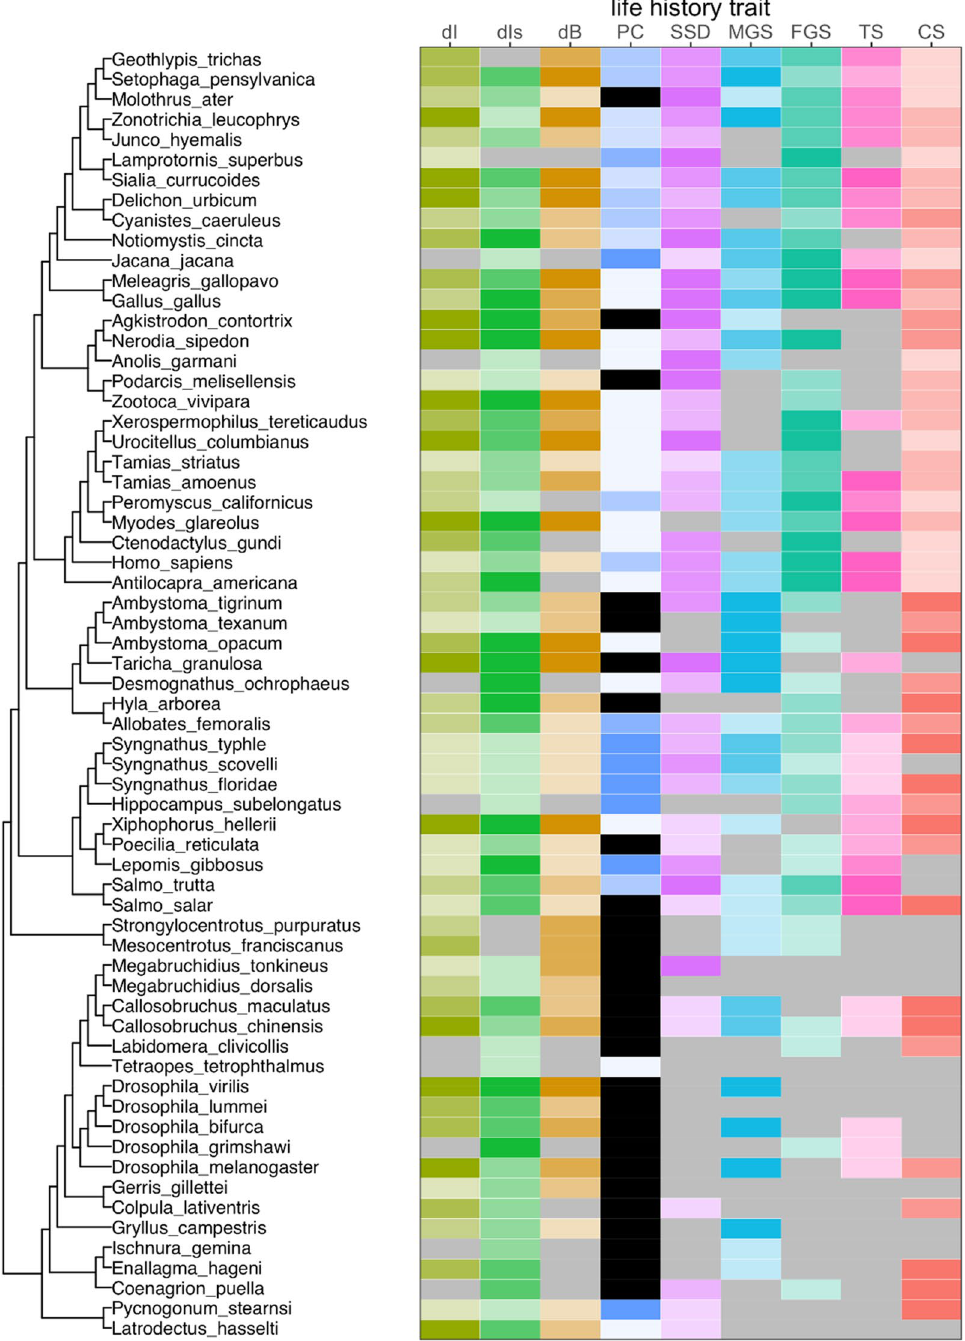
Figure 2. Phylogeny of species included in the study. Coloured cells indicate data extracted from Janicke et al. or the literature (see “Materials and methods”), whereas light grey cells indicats imputed data. Sexual selection was represented by three indices (dI—selection index ΔI, dIs—sexual selection index ΔI s , dB—Bateman gradient Δβ ss ), and life history by six variables (PC—parental care, SSD—sexual size dimorphism, MGS—male gamete size, FGS—female gamete size, TS—testis size, CS—clutch size). For each variable, we divided the data into quartiles and each shade indicates a different quartile from low (light) to high (dark), except parental care for which five levels of parental care were indicated using different shades that range from female-only care (light blue) to male-only care (dark blue). Black indicates no care. Parental care was not imputed. The figure was prepared using RStudio version 4.0.0 https:// www.R- proje ct.